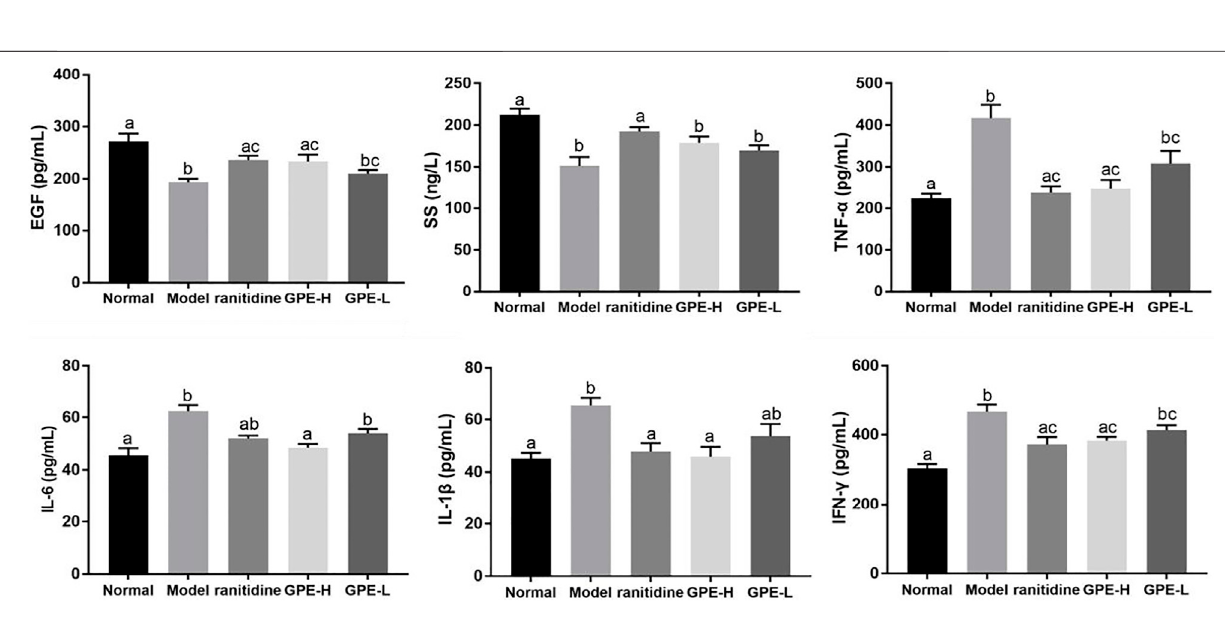
Frontiers in Pharmacology |